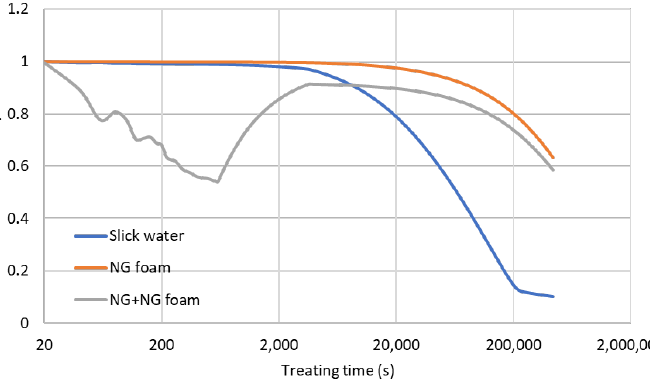
Figure 15. Fluid efficiency versus time during the hydraulic fracturing and shut-in time.